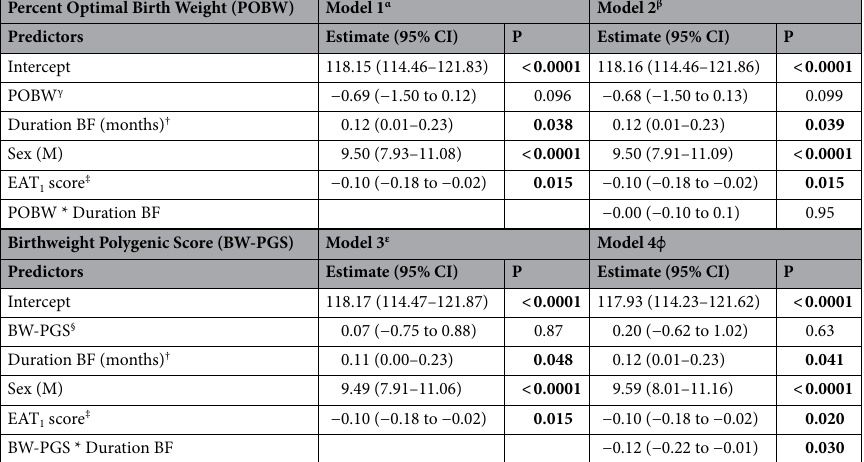
Model 4 examines the ϕ